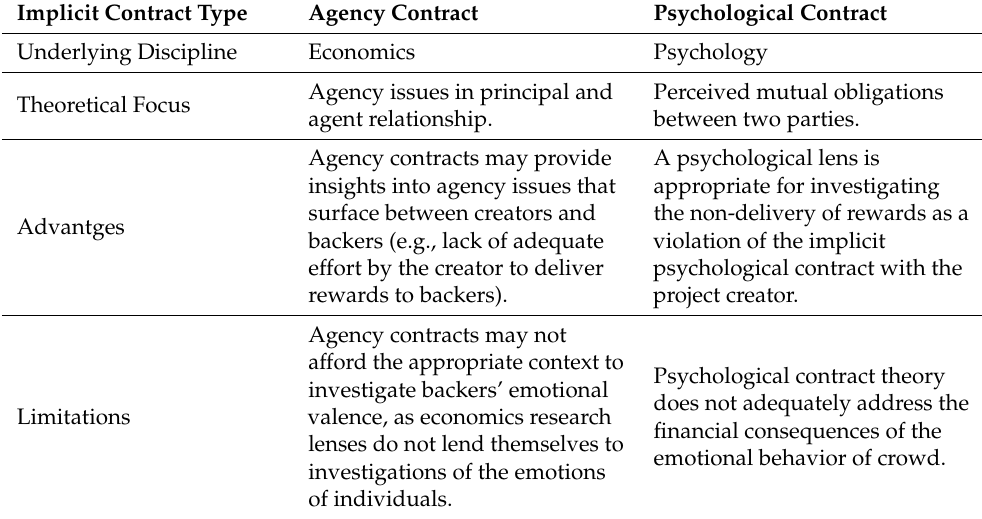
Table 1. Overview of two prominent theoretical lenses to investigate implicit contracts in en- trepreneurial failures to deliver in rewards-based